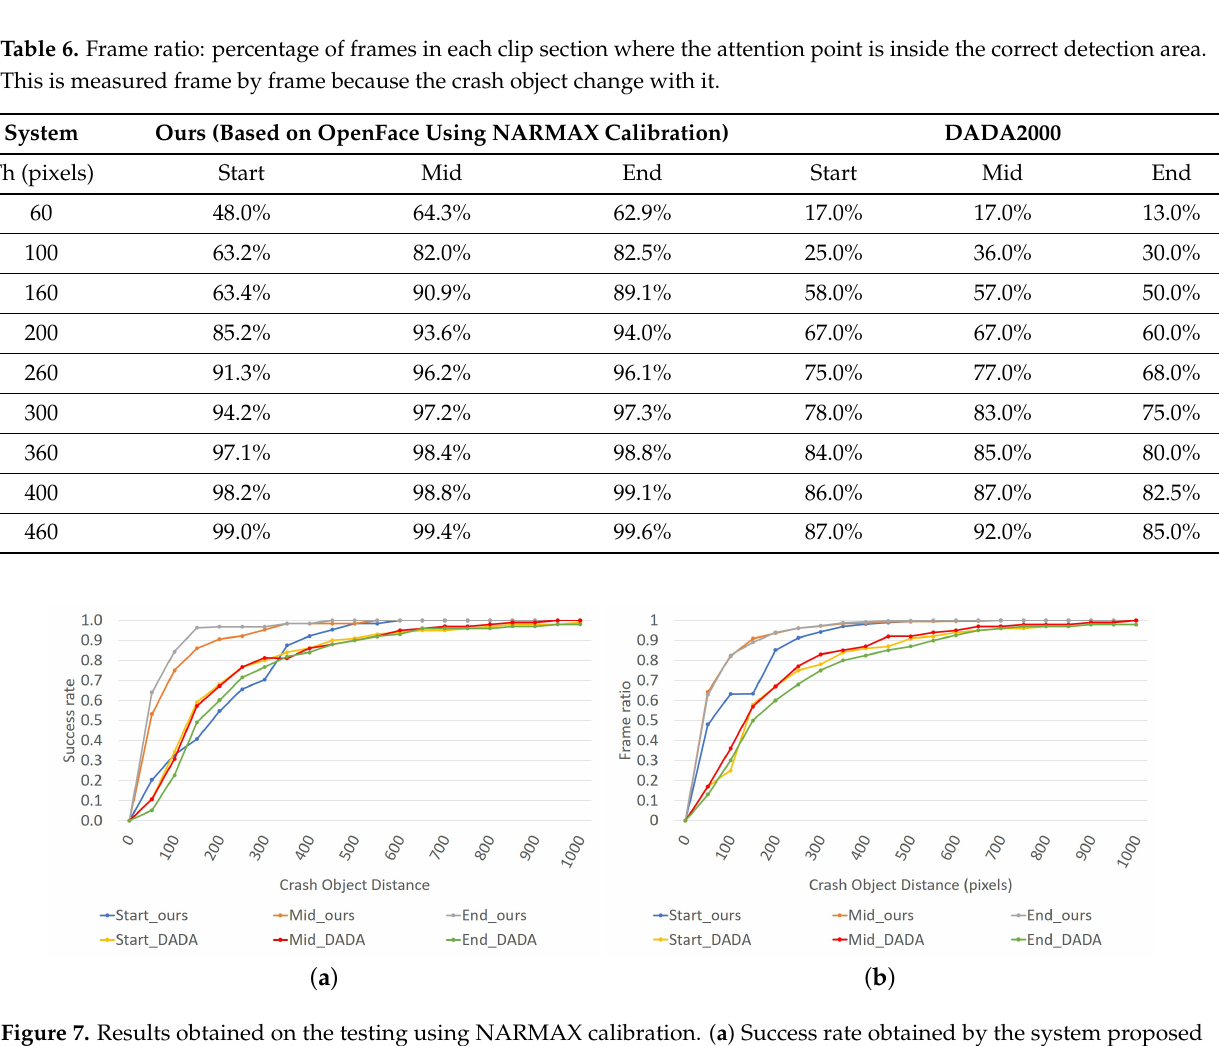
Figure 7. Results obtained on the testing using NARMAX calibration. ( a ) Success rate obtained by the system proposed using NARMAX calibration, ( b ) frame ratio obtained by the system proposed using NARMAX